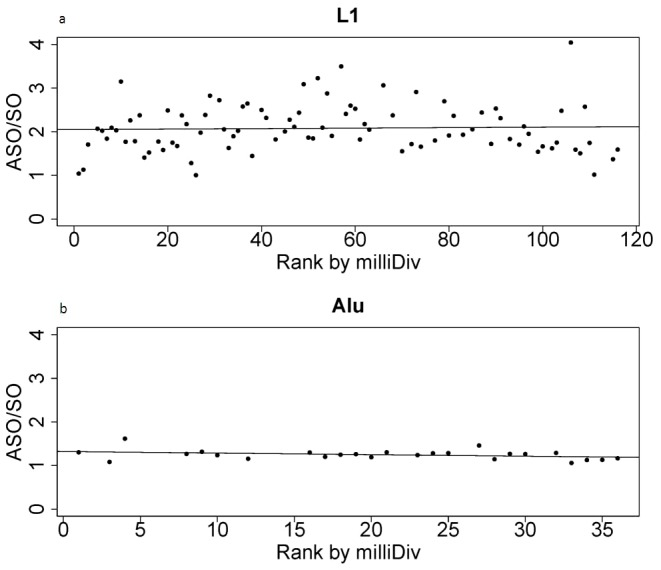
ASO/SO ratio remains consistent over time.Counts of all antisense oriented L1 in genes (ASO-L1) were compared to counts of all sense oriented L1 in genes (SO-L1) (a) and the counts of all antisense oriented Alu in genes (ASO-Alu) were compared to counts of all sense oriented Alu in genes (SO-Alu) (b). The resulting antisense to sense ratio (ASO/SO) was plotted by the subfamily rank as detailed in figure 2. Slopes of ASO/SO over subfamily rank were 0.0005 and −0.004 for L1 and Alu respectively.